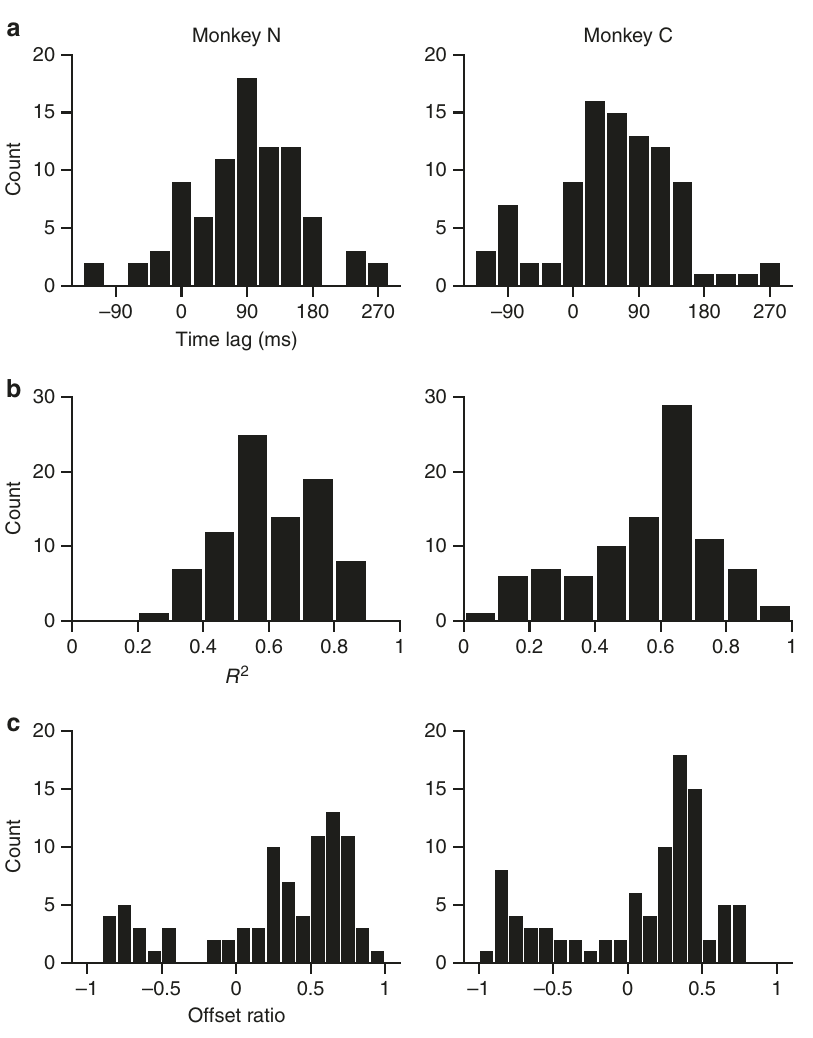
Fig. 2 Results of regression analysis for Monkey N (left column, 86 units) and Monkey C (right column, 93 units). For each monkey, the histograms in this fi gure summarize the results from all recorded units. a Histogram of the optimal time lags at which R 2 value is the highest among the sliding time window: − 120 to 270 ms. b Histogram of maximum R 2 values. c Histogram of offset ratios calculated at the optimal time